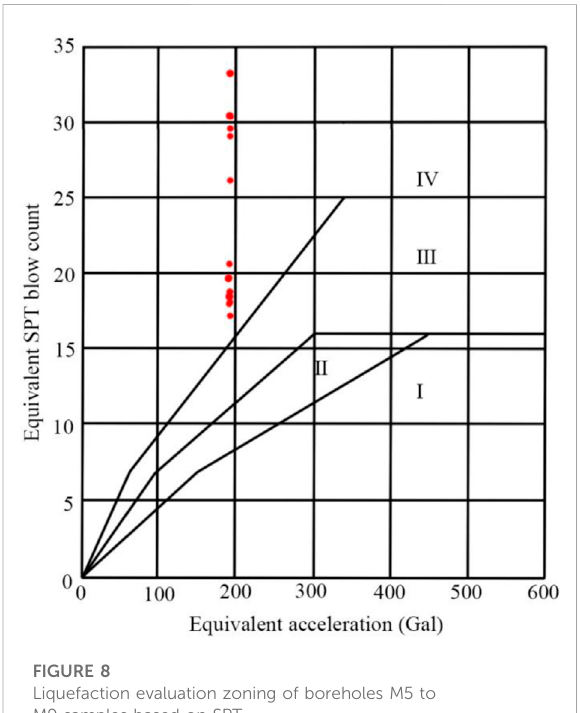
FIGURE 8 Liquefaction evaluation zoning of boreholes M5 to M9 samples based on SPT.